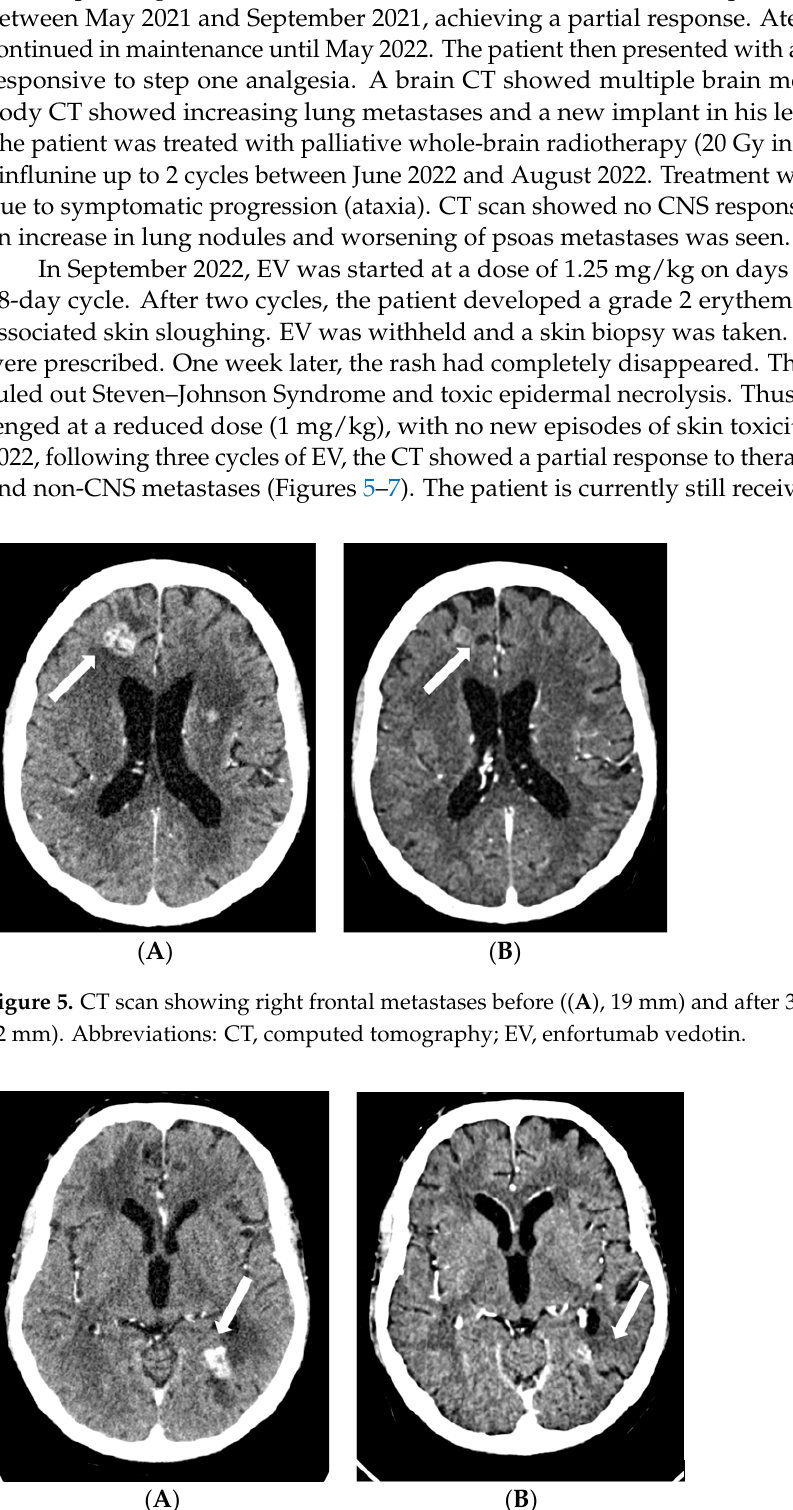
( B ) Figure 7. CT scan shows a left hilar lung lesion before start of EV (( A ), 43 mm) and after 3 cycles of EV (( B ), 23 mm). Abbreviations: CT, computed tomography; EV, enfortumab vedotin. 3. Discussion The most common sites of distant metastases of urothelial carcinoma are the lymph nodes, liver, peritoneum, lungs, and bones. Metastases to the CNS are rare and reported in around 1–8% of patients [11]. The primary approaches to the treatment of brain metas ‐ tases include surgery, stereotactic radiosurgery (SRS), or whole brain radiation. However, when surgery or SRS is not feasible, there are no data available to guide further systemic treatment. Previous research has shown that cytotoxic chemotherapies only have a limited effect on brain metastases. In addition, immune checkpoint inhibitors have also been in ‐ vestigated in patients with brain metastases and melanoma or lung cancer, which showed similar modest results. Thus, the data regarding the effects of anti ‐ cancer treatment on brain metastases are very limited. ADCs are an emerging class of anticancer drugs. They consist of tumor ‐ targeting monoclonal antibodies linked to highly cytotoxic payloads. More than a 100 ADCs are currently being investigated in clinical trials; however, the efficacy in brain metastases is often limited due to the poor penetration of the blood–brain barrier [12]. This is also re ‐ flected in the fact that ADCs have not yet shown remarkable clinical outcomes in patients with glioblastoma multiforme [13–15]. A potential way to overcome these poor responses is by using ADCs with an optimal drug ‐ to ‐ antibody ratio, allowing for an improved pay ‐ load delivery to the brain metastases. In addition, ADCs should be more homogeneously constructed as to the previous heterogeneous ADCs [12]. In heterogeneous ADCs, the drug is conjugated in random positions that can vary between the different monoclonal antibodies, whereas in homogeneous ADCs, the drug is fixed on specific sites of each monoclonal antibody molecule. For example, a post ‐ marketing observational case series